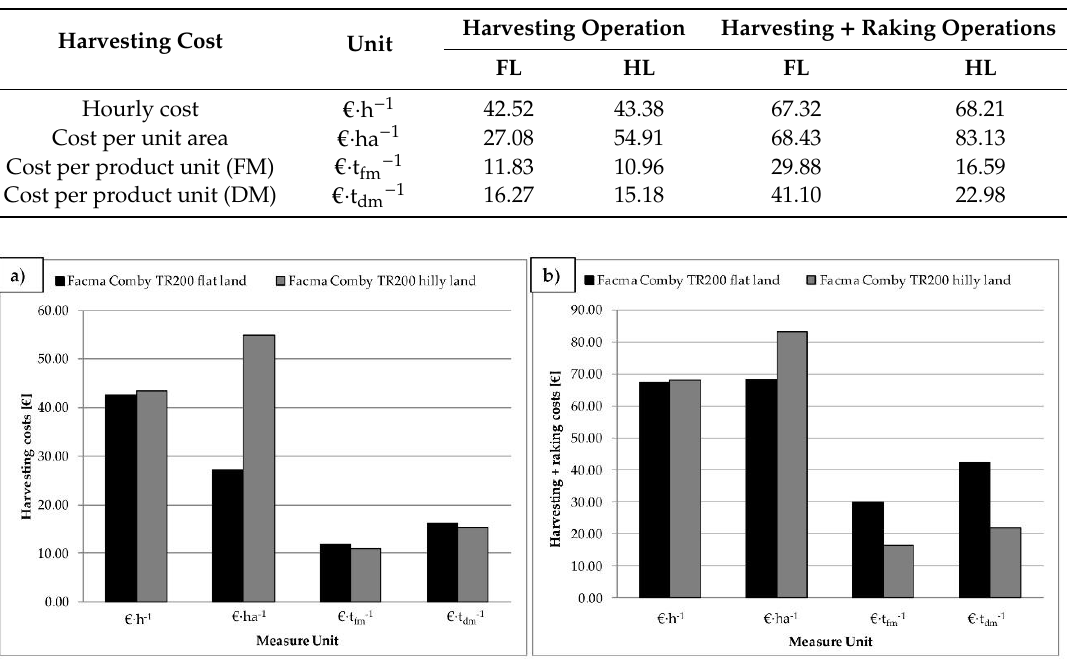
Table 6. Cost analysis results regarding the FL and HL experimental fields. “Harvesting Operation” refers to the costs of the Facma Comby TR200 and Ebro Model 85 tractors, while “Harvesting + Raking Operations” refers to the overall harvesting system’s costs, i.e., the Facma Comby TR200, Ebro Model